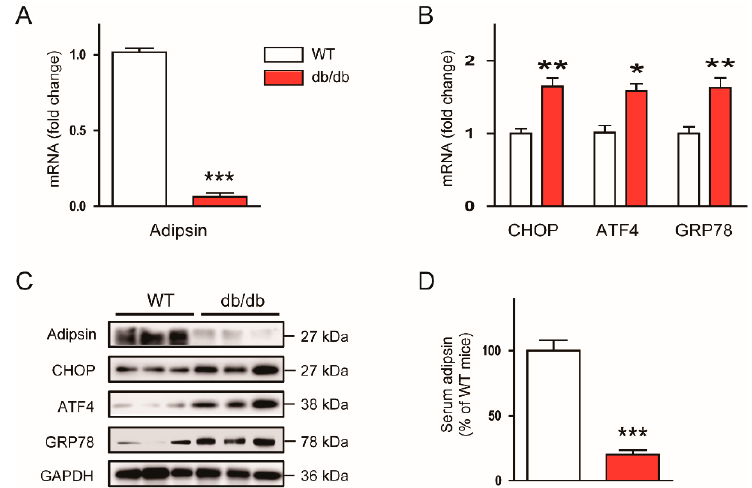
Figure 1. Adipsin expression is inversely associated with endoplasmic reticulum (ER) stress in vivo. To compare expression of adipsin and ER stress markers in gonadal white adipose tissues (gWATs) and serum between lean and obese mice, 10-week-old wild-type (WT) C57BL / 6N mice and db / db mice were sacrificed. ( A ) Real-time reverse transcription–polymerase chain reaction (RT-PCR) analysis of adipsin in gWATs. ( B ) Real-time RT-PCR analysis of C / EBP homologous protein (CHOP), activating transcription factor 4 (ATF4), and glucose-regulated protein 78 (GRP78) in gWATs. ( C ) Western blot analysis of adipsin, CHOP, ATF4, GRP78, and glyceraldehyde-3-phosphate dehydrogenase (GAPDH) in gWATs. GAPDH was used as a loading control. Each lane represents an individual animal. ( D ) Serum levels of circulating adipsin. n = 8 per group. All data are represented as the mean ± standard error of the mean (SEM). * p < 0.05, ** p < 0.01, and *** p < 0.001 vs. WT